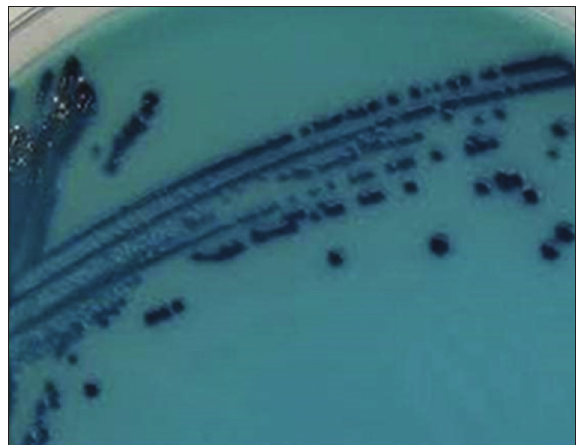
Figure-5: Typical blue colonies of Staphylococcus aureus on oxacillin resistance screening agar showing phenotypic methicillin resistant S. aureus isolates.